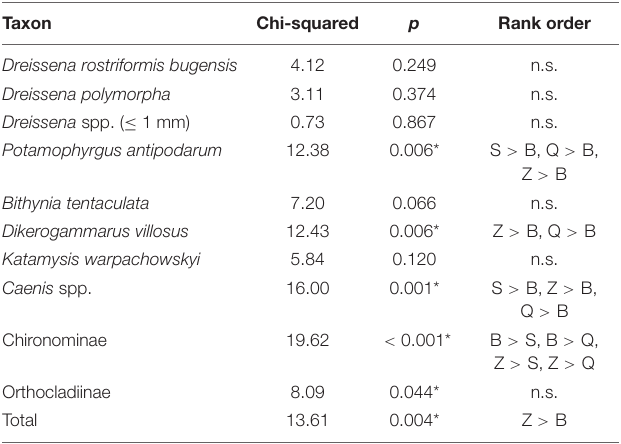
TABLE 1 | The differences in abundances of newly settled macroinvertebrates among four different